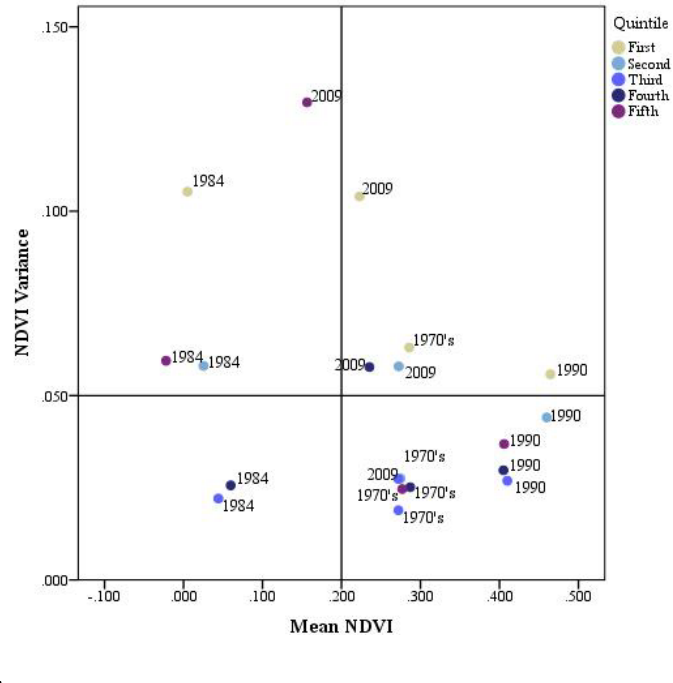
Figure 8. Results for mean variance analysis for each precipitation class (quintiles), with the first quintile representing the driest to the fifth representing the wettest areas on the